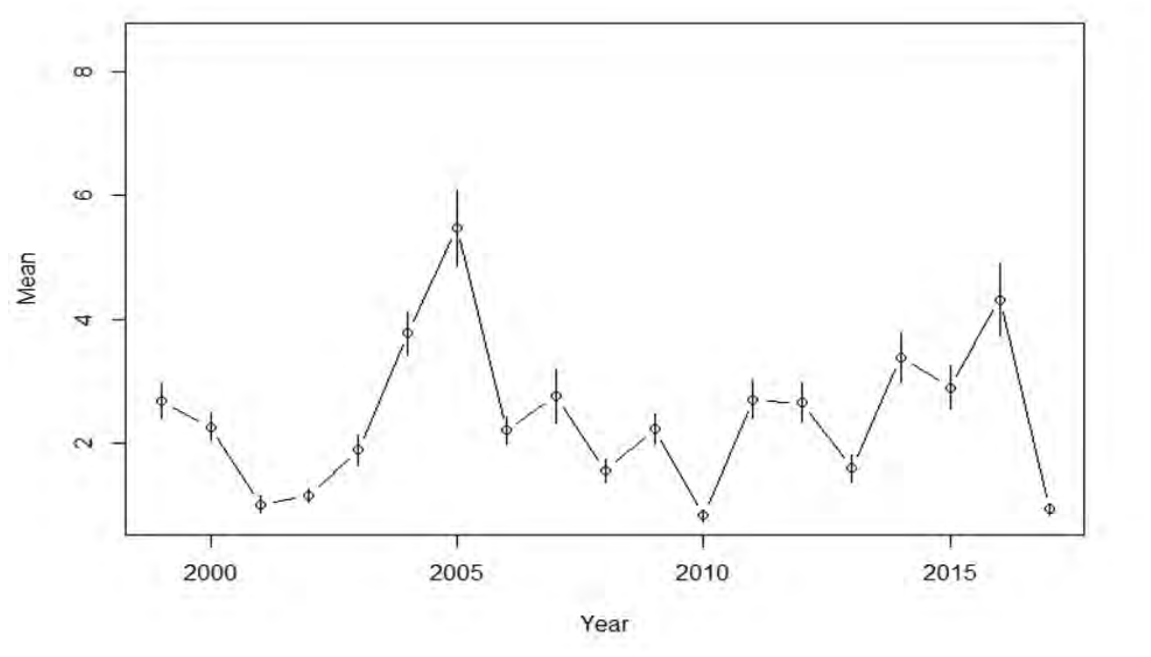
Figure 48. Abundance index for adult male horseshoe crabs in the fall (October) from New Jersey’s Ocean Trawl